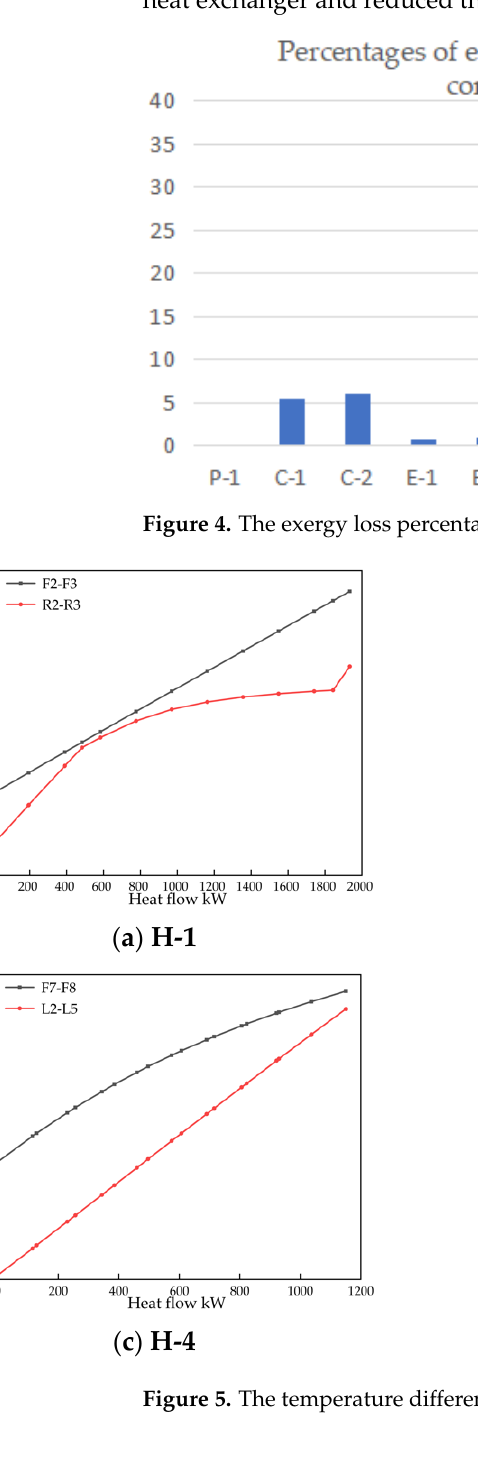
( d: H-5 ) Figure 5. The temperature difference and heat flow in heat exchangers. 4.3. Sensitivity Analysis of Key Parameters on the System Performance 4.3.1. Working Fluid Evaporation Pressure The evaporation pressure of the working fluid will affect the net work and efficiency of the ORC. The effect of the working fluid evaporation pressure on system performance is shown in Figure 6. The electricity consumption and energy consumption of the system increased with the increment of the evaporation pressure of the ORC working fluid. Ac- cording to the P–H phase diagram (Figure 7) of the working fluid, with the increase in the ORC working fluid evaporation pressure, the cold energy required for the condensing working fluid in the H-5 heat exchanger decreased, and the cold energy released in the heat exchanger H-1 and H-2 decreased at the same time. This then led to a decrease in the SCV inlet LNG temperature and an increase in compressor inlet temperature for compres- sors C-1 and C-2, which increased SCV fuel gas consumption, power consumption, and